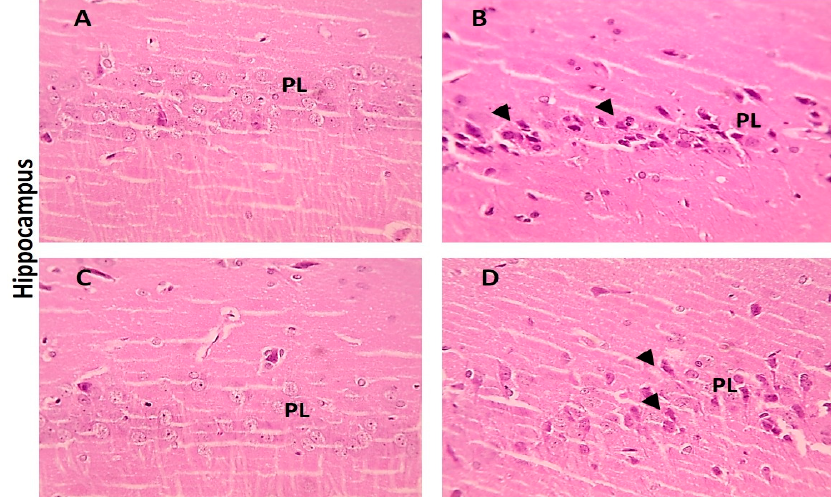
Figure 10. Histopathological examination of hippocampal sections using H&E. ( A ) and ( C ) Hippo- campal section showing normal neurons in the pyramidal layer (PL) (H&E, 400×). ( B ) Hippocampal section showing marked degeneration and shrinkage of neurons in the pyramidal layer (PL) (H&E, 400×). ( D ) Hippocampal section showing mild degeneration and shrinkage of a few neurons in the pyramidal layer (PL) (black arrowheads) (H&E, 400×). (G) granular cell layer, (P) Purkinje layer and (M) molecular cell layer.